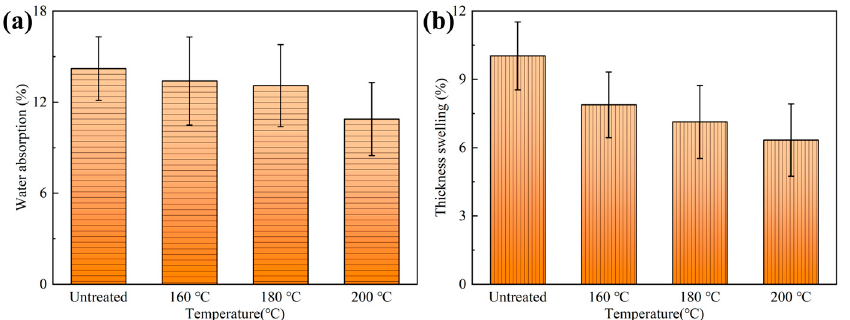
Figure 6. (a) Water absorption and (b) thickness swelling of scrimbers made from heat treated